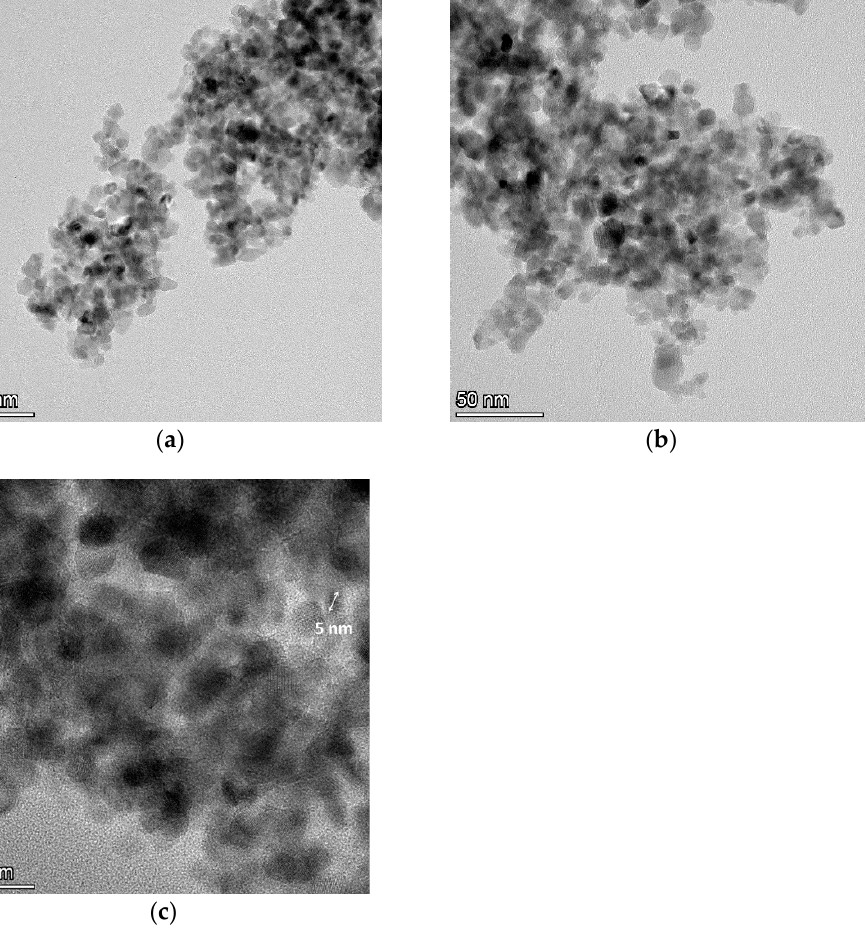
Figure 7. TEM images of the as prepared N-TiO 2 nanoparticles in ( a ) ×190,000, ( b ) ×245,000, and ( c ) ×500,000 magnification.